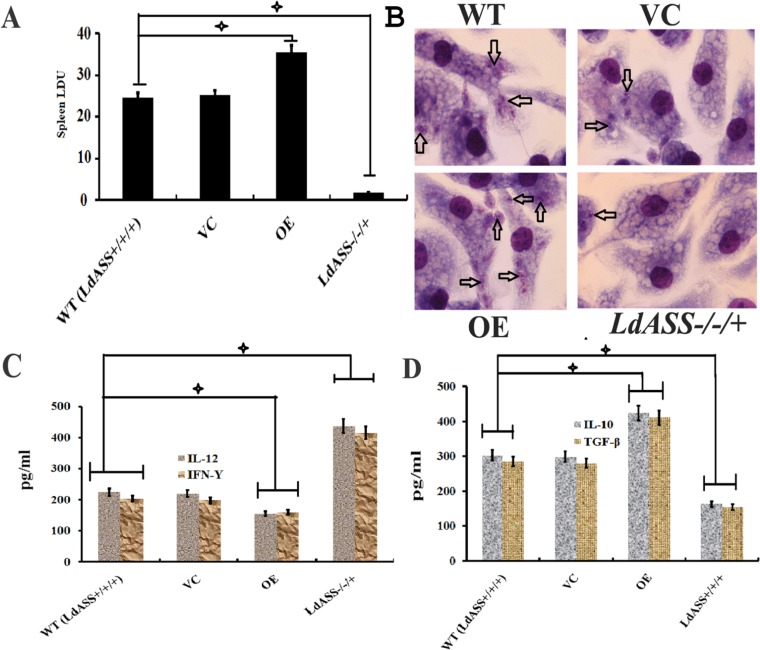
Infectivity of LdASS mutants in the murine model.A) BALB/c mice were infected with WT, VC, OE and LdASS-/-/+ cell lines of L. donovani. After four weeks infected mice were sacrificed and parasite load was determined by counting the no. of amastigotes per100 macrophages (Mϕ) in spleen. The parasite burden in spleen was found to decrease by ~4 fold in LdASS-/-/+ cell line but increased by ~2.3-fold in OE cell line compared to WT and VC cell lines. B) Phase contrast microphotograph after Geimsa staining of PECs containing murine peritoneal macrophages infected with different L. donovani cell lines (WT, VC, OE and LdASS-/-/+). C & D) IL-12, IFN-γ, IL-10 and TGF-β Cytokine level were measured in murine peritoneal macrophages infected with different L. donovani cell lines (WT, VC, OE and LdASS-/-/+). In the LdASS-/-/+ parasites, the IL-12 and IFN-γ were increased whereas IL-10 and TGF-β were decreased compared to WT parasites. Each measurement was performed in triplicate and data are expressed as the mean. Vertical lines on top of the bars represent s.e. values and star symbol above the vertical lines denotes significant changes with P<0.05.